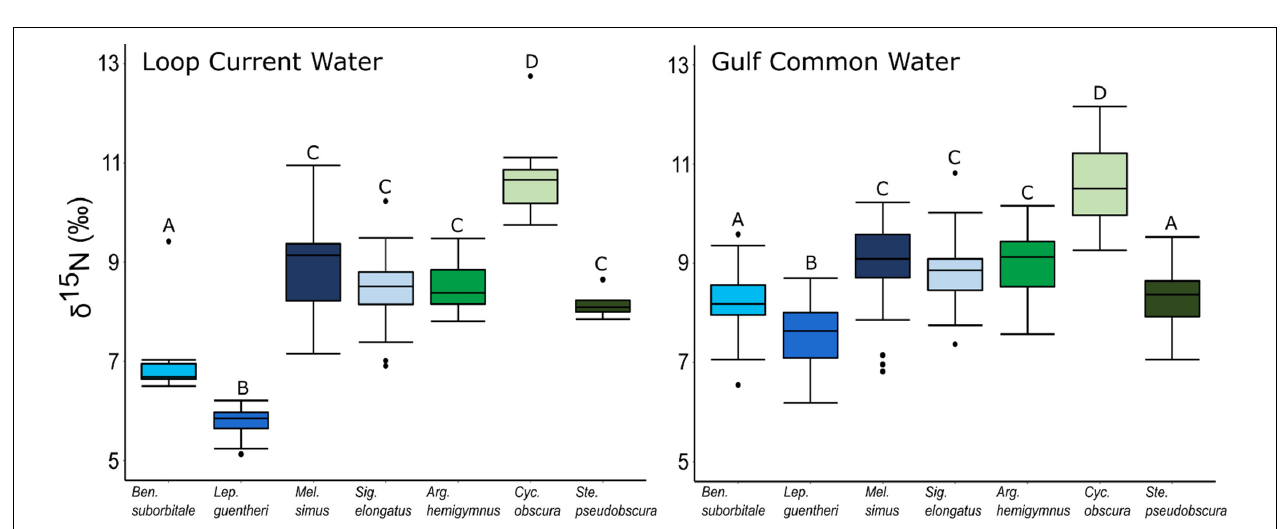
FIGURE 4 | Boxplots depicting interspecific differences in mean ( ± SD) δ 13 C values for migratory (blue shades) and non-migratory (green shades) deep-pelagic fishes collected in Loop Current water and Gulf common water. Differing letters among species denote significant differences.